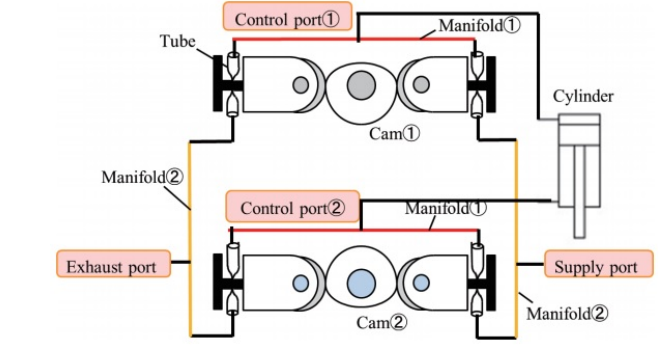
Figure 6. Port connections by manifolds.